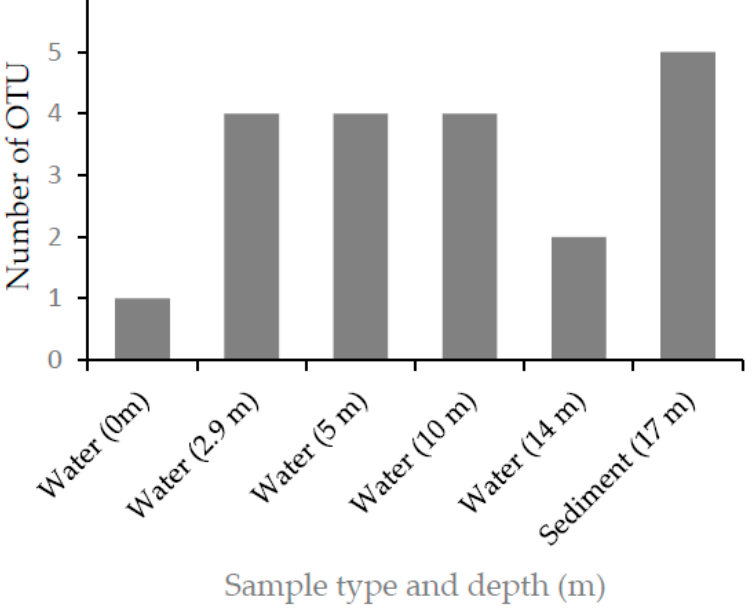
Figure 3. Depth distribution of nitrogen-fixing OTUs isolated from Lake Chitu.